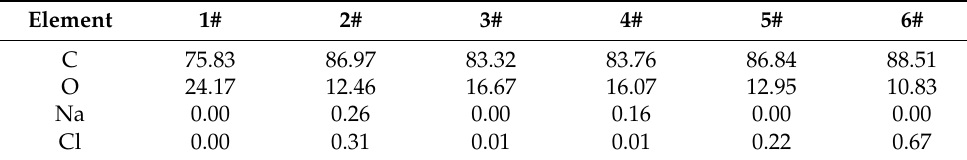
Figure 3. Two-dimensional and three-dimensional morphology of porous samples: ( a ) Sample 2#; ( b ) Sample 3#; ( c ) Sample 4#; ( d ) Sample 5#; ( e ) Sample 6#. Table 4. Percent elemental content of porous